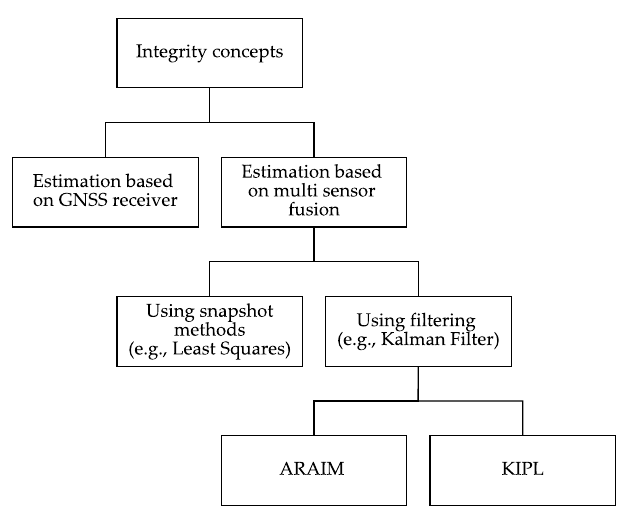
Figure 2. Decision tree for integrity concepts (representation not